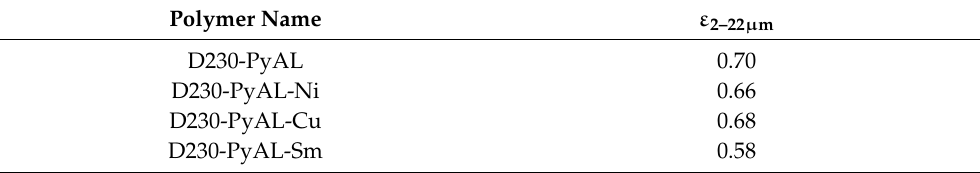
Table 3. Infrared emissivity values of polymers and coordination polymer coatings.